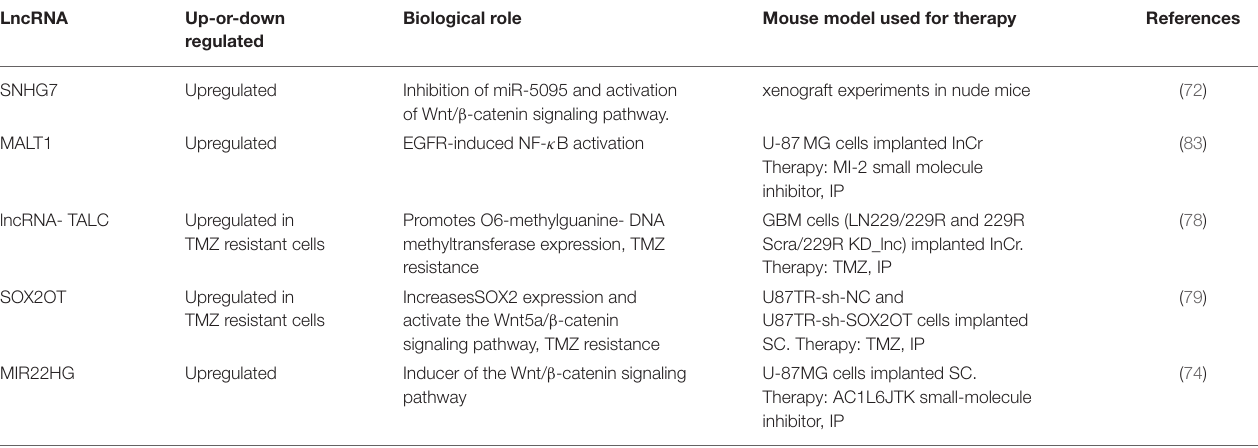
TABLE 2 | List of relevant deregulated lncRNAs proposed as therapeutic targets against GBM (GBM mouse models used in the study).